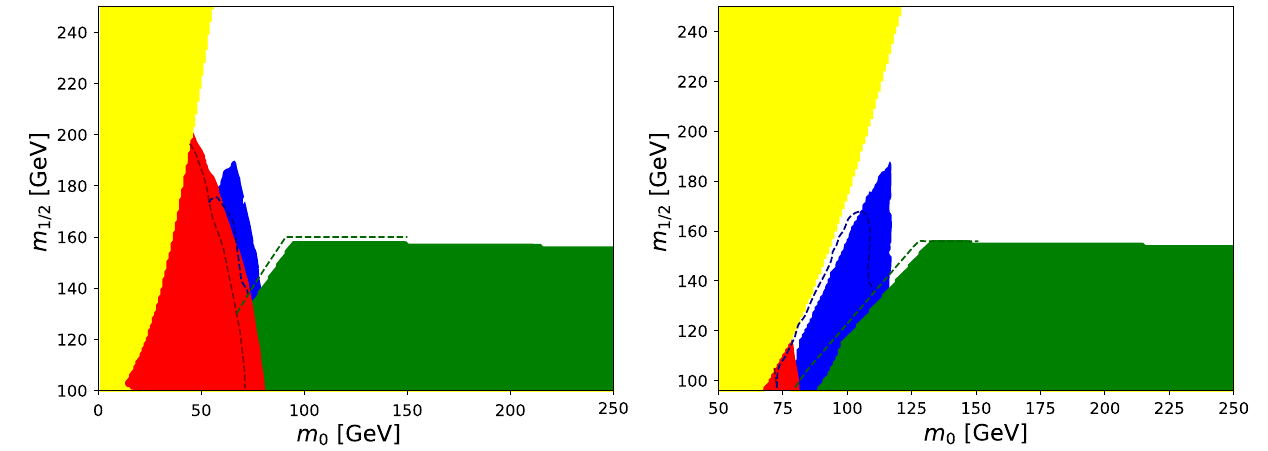
Fig. 8 Limits from direct sparticle pair production searches at LEP shown in the CMSSM ( m 0 , m 1 / 2 ) -mass plane with fixed tan β = 15 (left) and tan β = 30 (right), A 0 = 0 GeV and μ > 0. The 95% CL excluded areas from chargino searches (green), stau searches (blue), and selectron searches (red) are shown separately and overlaid in the